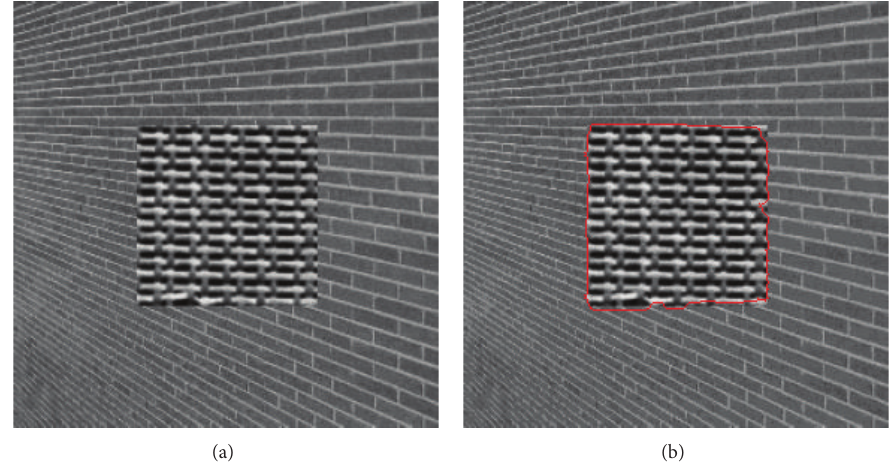
Figure 2: An image of a “chirp-like” brick-wall background and a Brodatz texture object. (a) Original image and (b) the segmentation